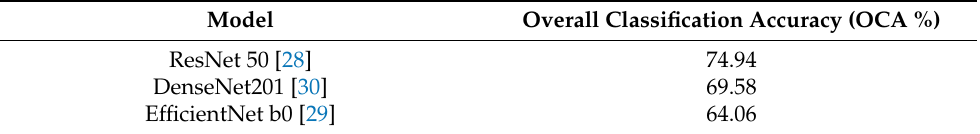
Table 3. The performance comparison on the DDSM dataset using different convolutional neural networks (CNN).